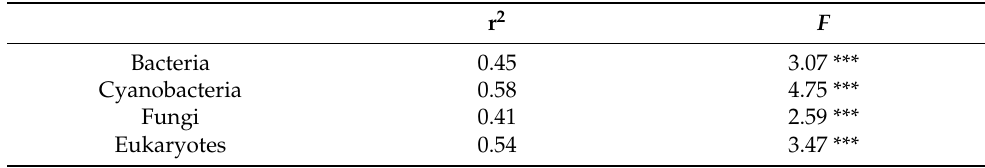
Table 2. Differences in microbial community composition among five sites revealed by PERMANOVA (9999 permutations). Asterisks corresponds to the level of significance (*** p < 0.001). Pairwise comparisons are shown in Supplementary Materials Table